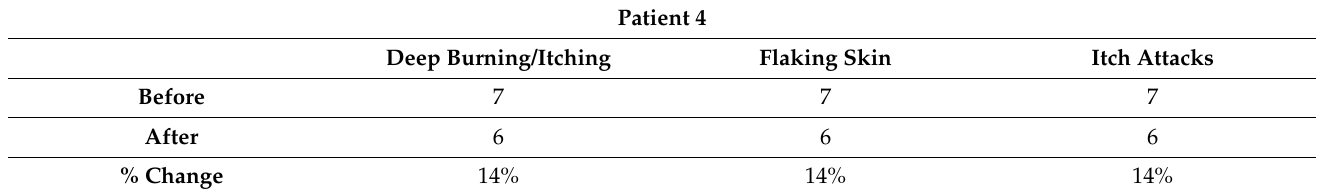
Table 6. Severity scores for Patient 4 before and after completing the study. The numbers in the table are out of ten, with ten being the worst severity, and zero meaning the symptom has ceased to exist. The percentage change in the severity of each symptom is shown in the bottom row.